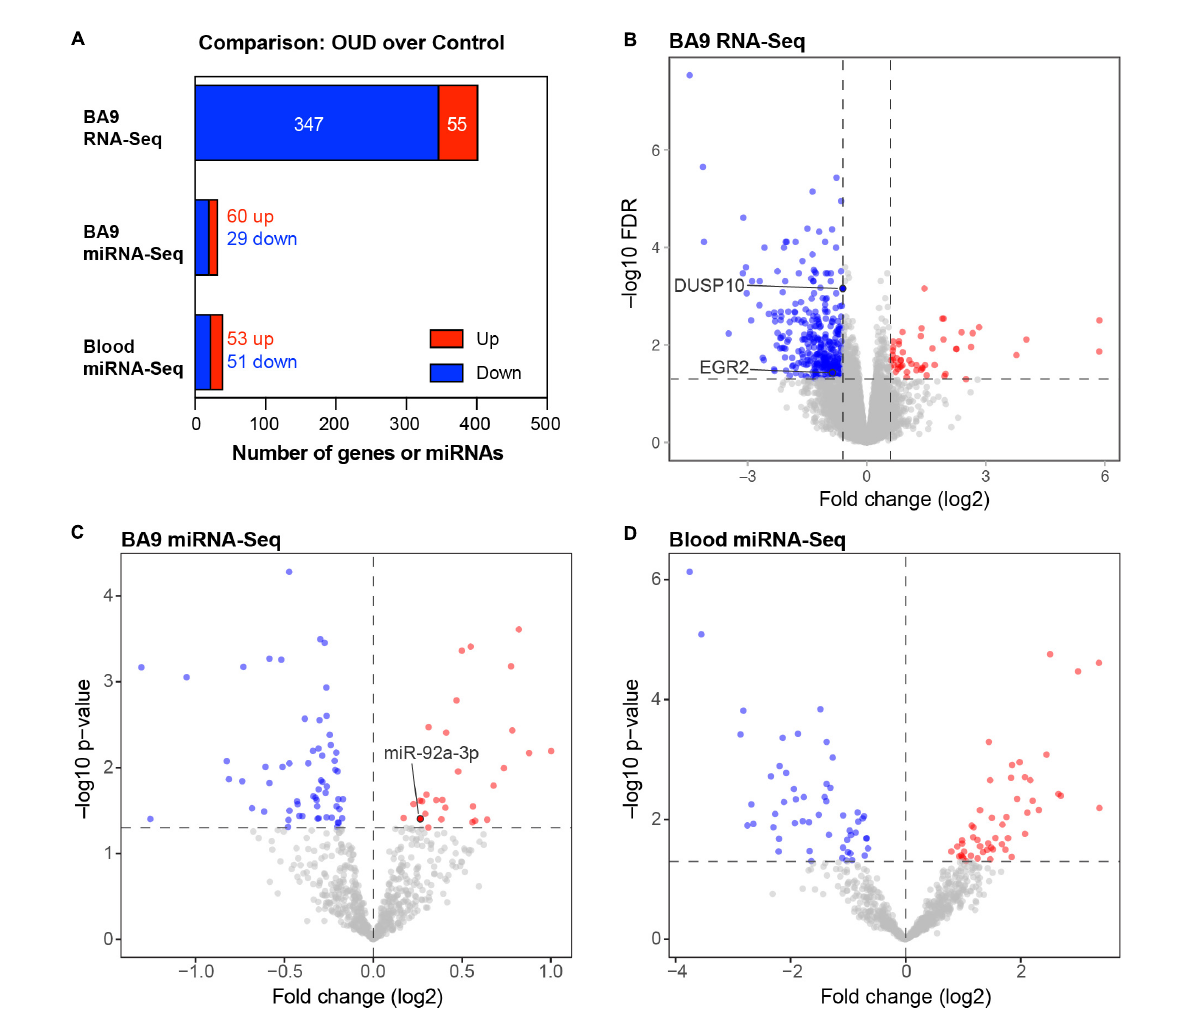
FIGURE2 Differentially expressed protein-coding genes and microRNAs in brain and blood from individuals with opioid use disorder (OUD). (A) Summary of differentially expressed miRNA–mRNA network components. Volcano plots of BA9 protein coding genes (B) , BA9 miRNAs (C) , and blood miRNAs (D) , comparing OUD to controls. Genes highlighted in panel (B) , DUSP10 and EGR2, are targeted by miR-92a-3p, highlighted in panel (C)